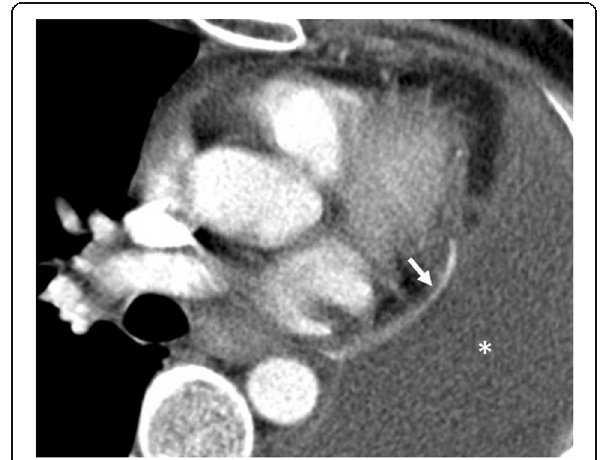
Fig. 21 A 80-year-old man with echocardiographic findings suggestive of restrictive physiology due to pericardial effusion. Axial contrast-enhanced CT image demonstrates a drainage catheter coursing within pericardial space (arrows)